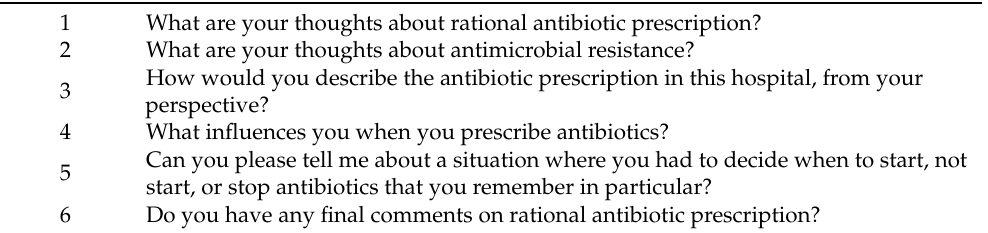
Table 3. Summarized interview guide (full version in Supplementary Materials File